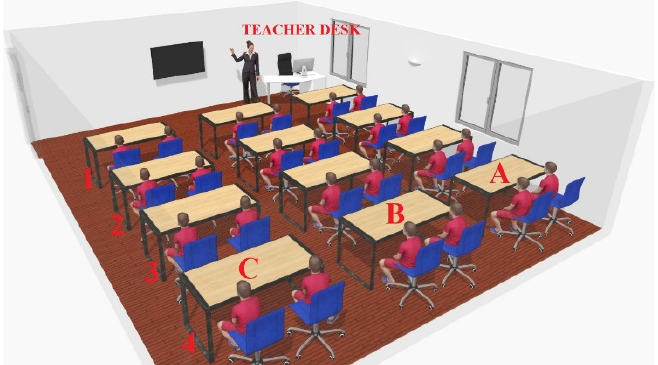
Figure 13. Coding that represents students’ positions .